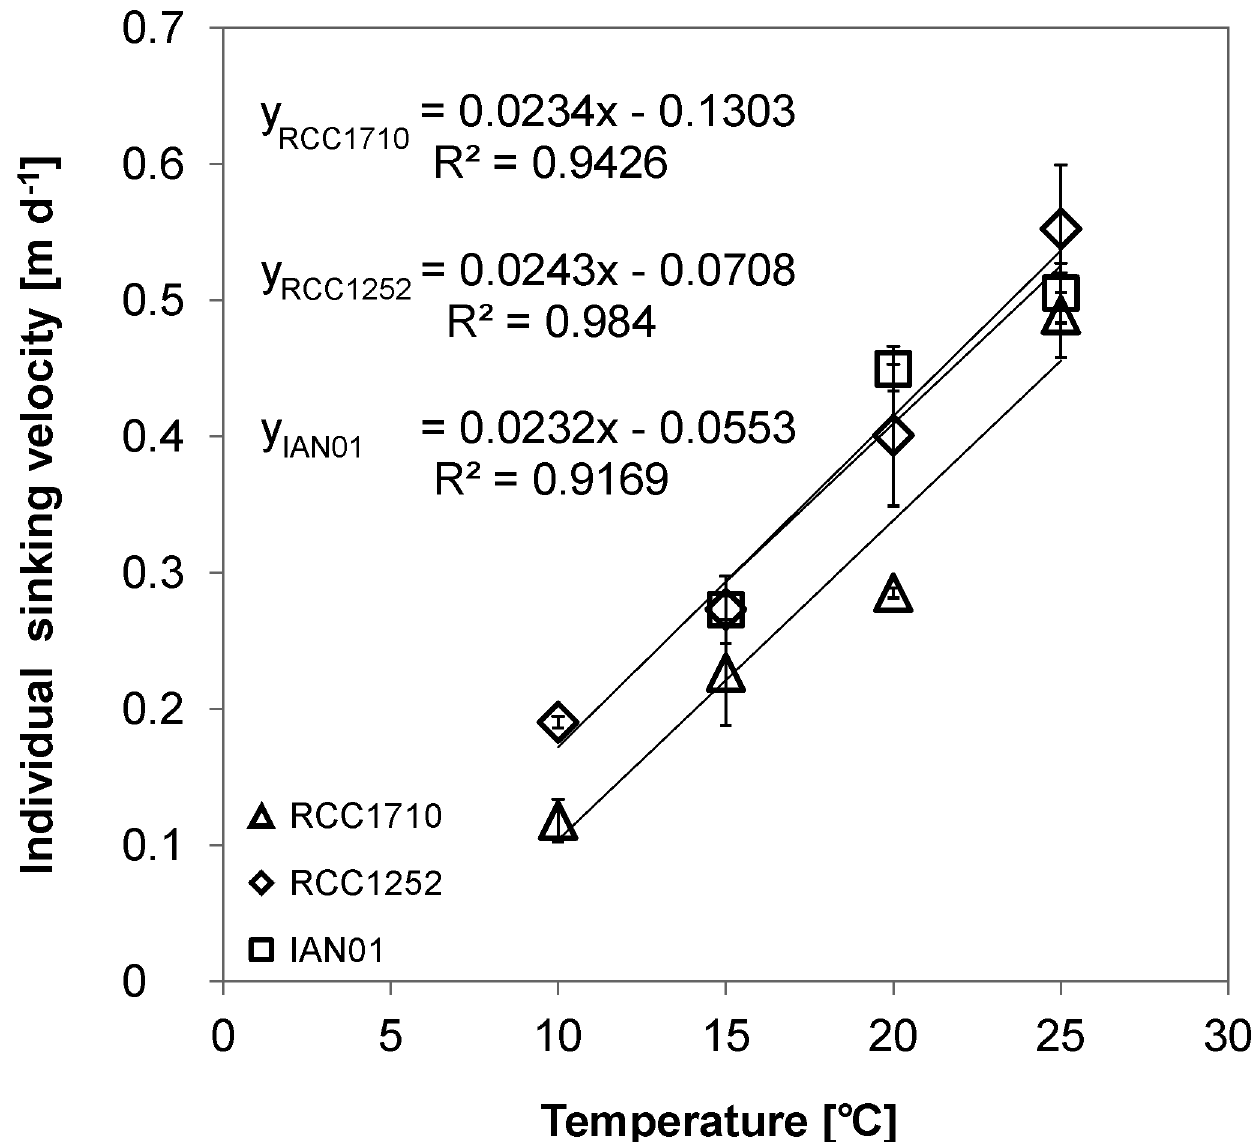
Fig 3. Changes in the individual sinking velocity calculated for three different strains of E . huxleyi grown at different temperatures. Strain RCC1710 (triangle symbols), strain RCC1252 (diamond symbols), and strain IAN01 (square symbols). Standard deviations of the triplicate experiment results, linear trend lines, corresponding equations, and r-squared values are